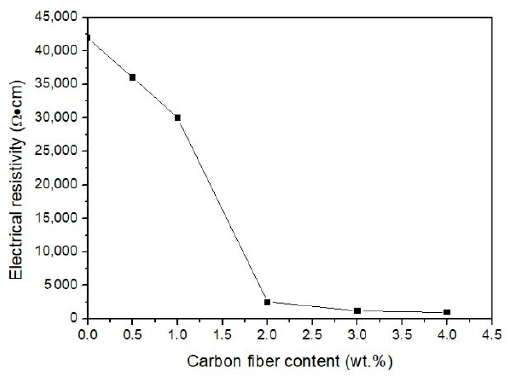
Figure 7. Electrical resistivity of the composites with different carbon fiber contents.